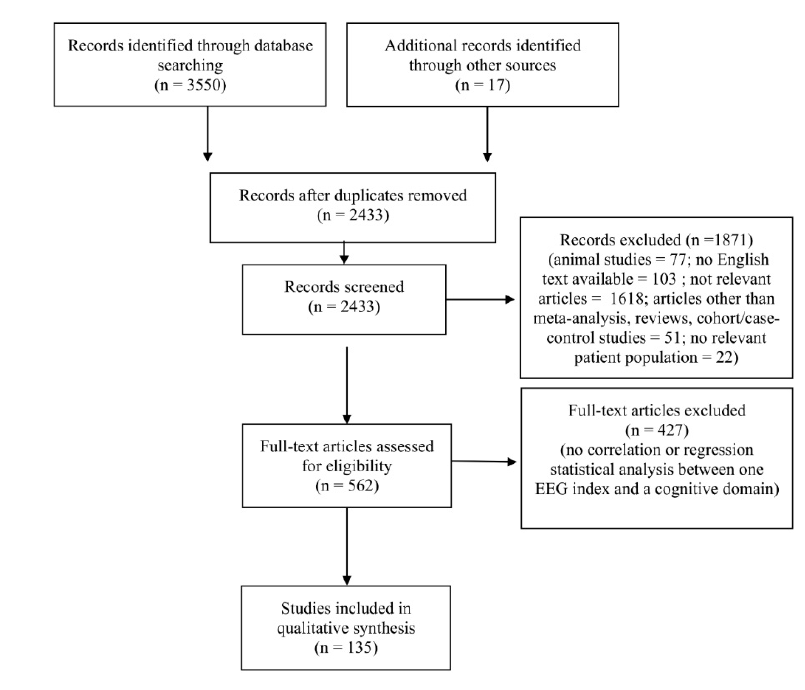
Figure 1. PRISMA flow chart of included studies. The PRISMA diagram details the search and selection process applied during our systematic literature search and review.